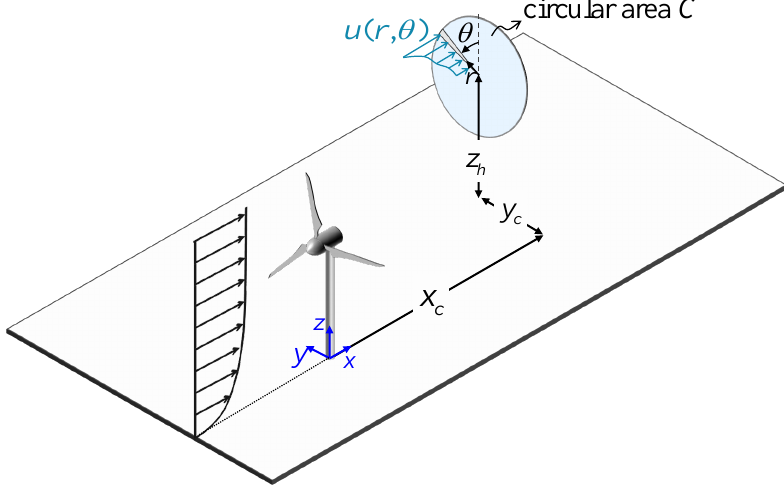
Figure 12. Schematic of the circular plane C where a hypothetical downstream turbine is